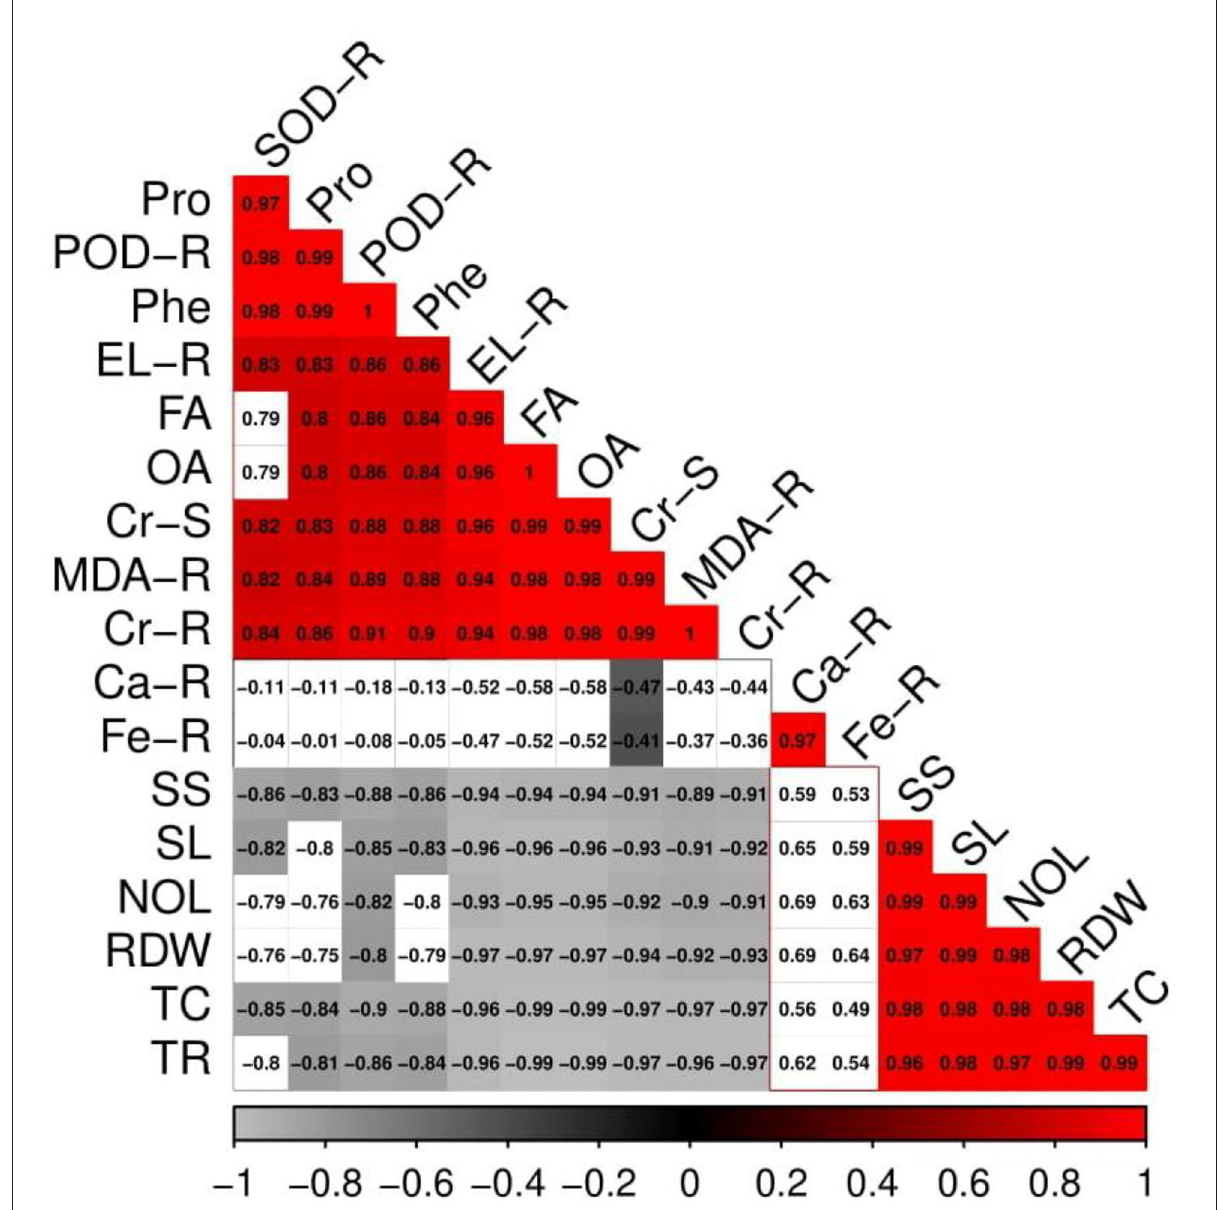
FIGURE8 Correlation between Cr uptake in different parts of the plant and some selected traits of morphological attributes, photosynthetic efficiency, oxidative stress and response of antioxidant enzymes, nutrient uptake, and organic acid exudation pattern. Different abbreviations used in the figure are as follows: SOD-R, superoxidase dismutase activity in the roots; Pro, proline content; POD-R, peroxidase activity in the roots; Phe, phenolic content; EL-R, electrolyte leakage in the roots; FA, fumaric acid content; OA, oxalic acid content; Cr-S, chromium content in the shoots; MDA-R, malondialdehyde content in the roots; Cr-R, chromium content in the roots; Ca-R, calcium content in the roots; Fe-R, iron content in the roots; SS, soluble sugar content; SL, shoot length; NOL, number of leaves; RDW, root dry weight; TC, total chlorophyll content; TR, transpiration